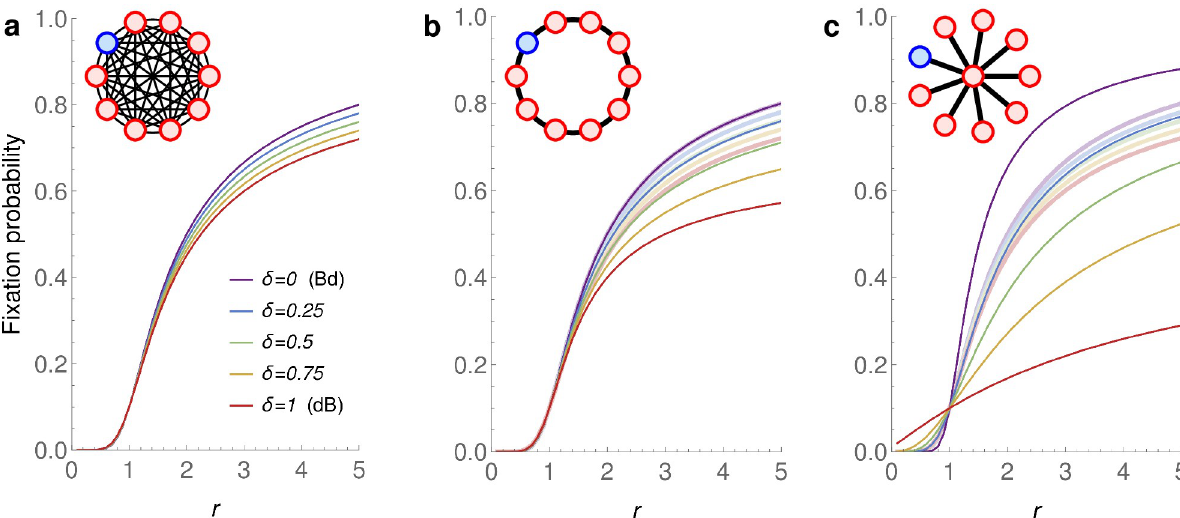
Fig 5. Fixation probability under δ -dB updating. Three different graphs on N = 10 vertices: a Complete graph, b Ring graph, c Star graph. For each δ 2 {0, 0.25, 0.5, 0.75, 1} we show the fixation probability under δ -dB updating as a function of r . For reference, we show the Complete graph again in panels b , c (thick faint lines). On the latter two graphs, the dependence of the fixation probability on δ is more pronounced and not roughly linear as is the case for the Complete graph. Due to the isothermal theorem [16], the Complete graph and the Ring have the same fixation probability under Bd updating ( δ = 0). The Star graph is an amplifier under Bd updating and also a δ -dB r -amplifier for small δ and r > 1 (e.g. for ; r Þ > 0 : 494 > 0 : 491 > ^ r d ð K ; r Þ ) but ceases to be an amplifier for large δ (e.g. for δ = 0.5 and r = 2 we have δ = 0.2 and r = 2 we have r d ð S 10 10 r d ð S ; r Þ < 0 : 37 < 0 : 47 < ^ r d ð K ; r Þ ). 10 10